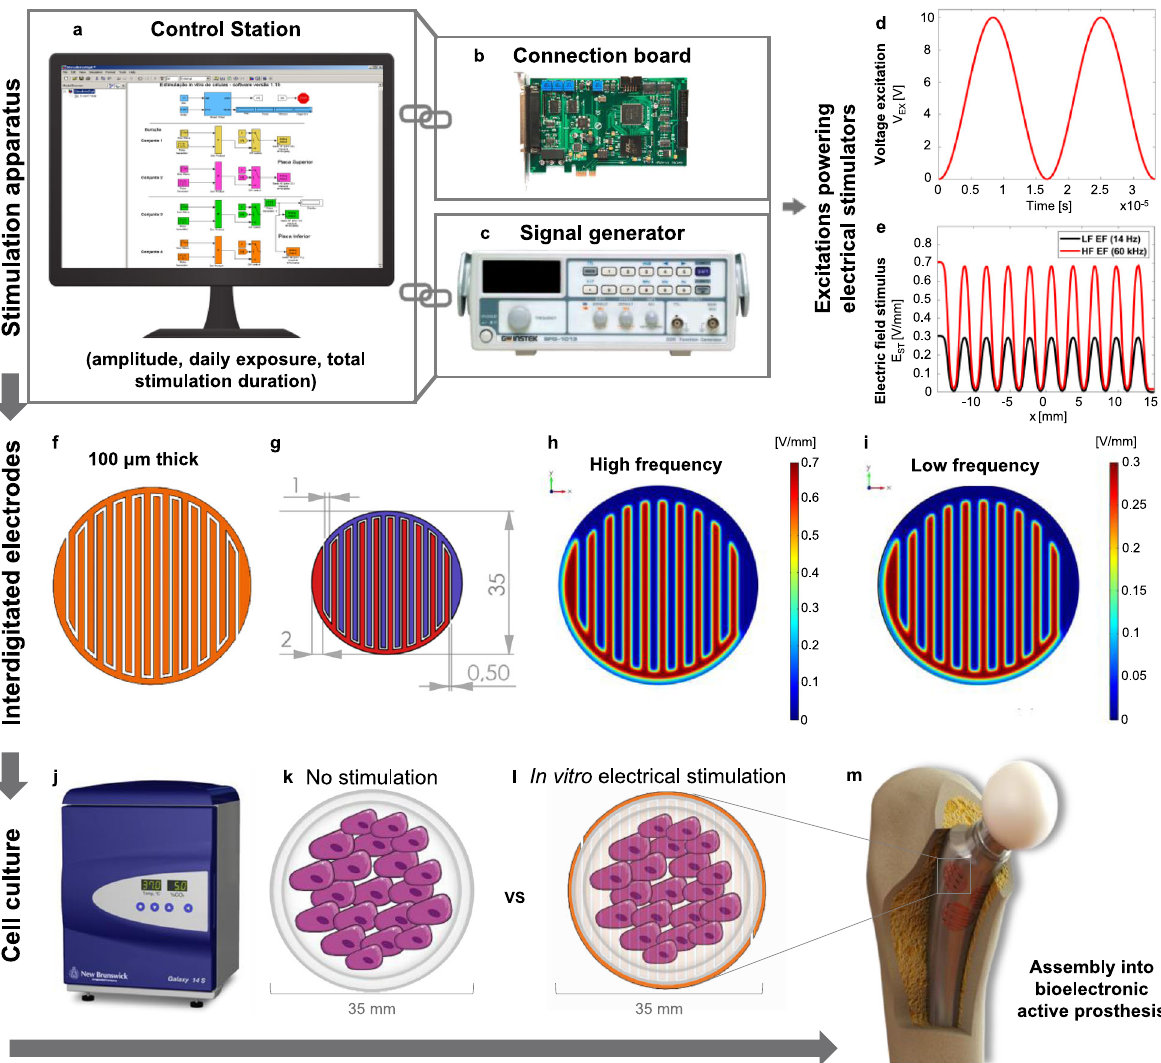
Fig. 1 Outline of the capacitive stimulation device used for cells electrical stimulation. The stimulation apparatus comprises a control station ( a ) coupled to an I/O cardboard ( b ) for signal conditioning, and a signal generator ( c ) that ensures the generation of high-frequency (HF) excitations. The control station runs a real-time application that con fi gures the excitation amplitude, daily exposure, and total stimulation duration. HF voltage excitations (60 kHz) have a de fi ned waveform ( d ). Maximum electric fi eld (EF) stimuli [0.7 vs 0.3 V/mm] are delivered for high- (60 kHz) or low-frequency (LF; 14 Hz) excitations ( e ), as predicted by a fi nite element computational model implemented using COMSOL Multiphysics (v. 5.3). The 100- μ m-thick cosurface interdigitated electrodes ( f ) have a 35 mm diameter architecture (measures in mm in g ). The electrode delivers frequency- and region-dependent EF stimuli to cells, with maximum EFs imposed over positively-charged electrodes and minimum EFs over the grounded electrodes. Stimuli distribution and strength along the xy -plane was determined under high- ( h ) and low-( i ) frequency stimulation. In vitro stimulation was performed inside an instrumented CO 2 incubator ( j ) connected to the stimulation apparatus, and cultures were grown in 35 mm culture dishes. The incubator contains both the control culture dishes ( k ) and the dishes receiving electrical stimulation, which are placed above each stimulator ( l ). These thin 35 mm electrodes are planned for assembly into bioelectronic active implants ( m ) to improve osseointegration around the bone – implant